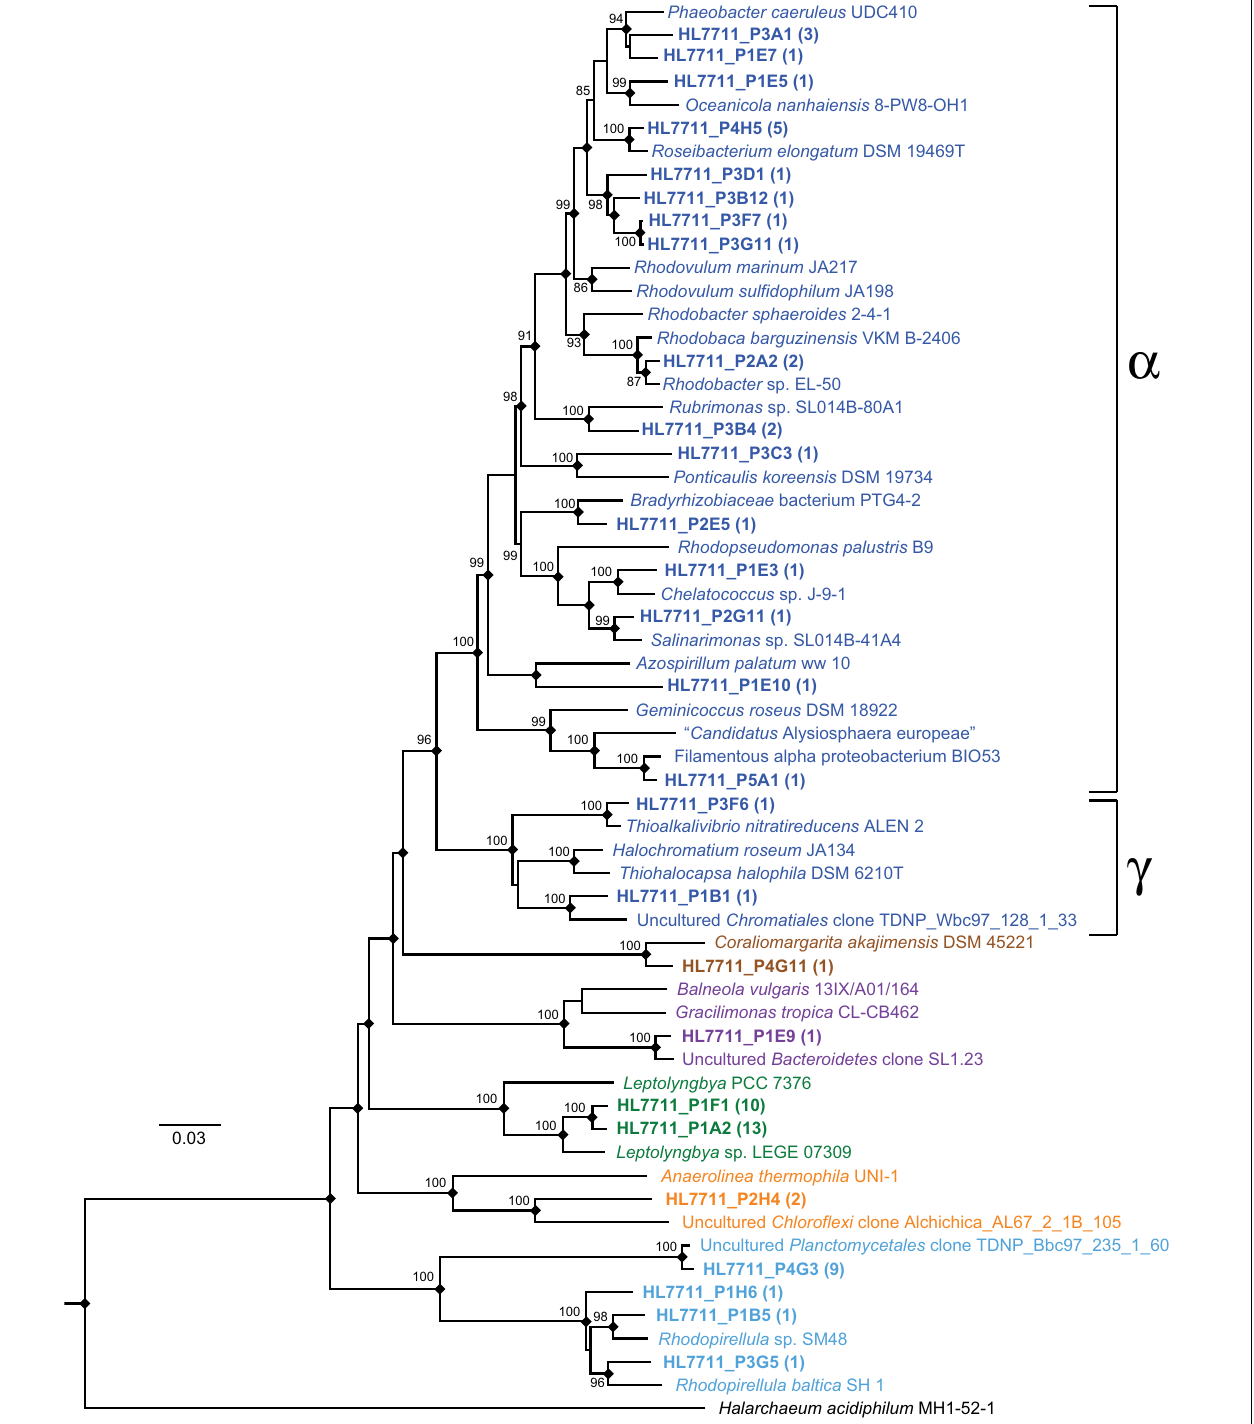
duplicated using a maximum-likelihood algorithm employing the general time-reversible model are notated with a diamond. Values near nodes represent neighbor-joining bootstrap values greater than 80. Terminal node colors denote phyla according to the same scheme used in Figure 6A . Classes Alphaproteobacteria and Gammaproteobacteria are enclosed in